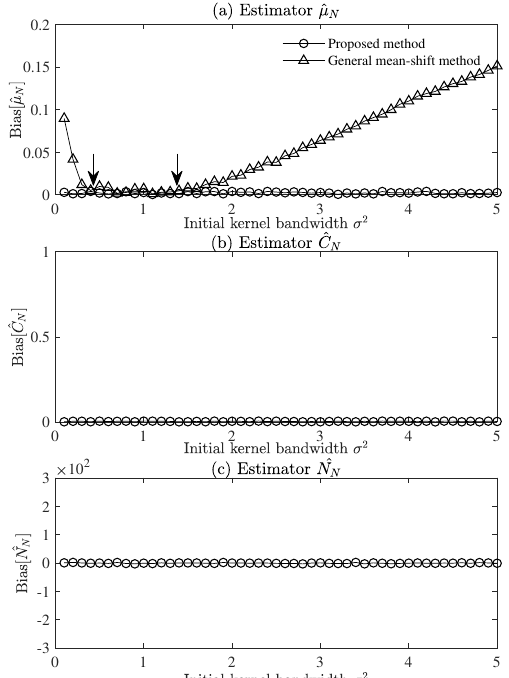
Figure 4. Bias errors for various initial kernel bandwidths σ 2 in the proposed method and the general mean-shift